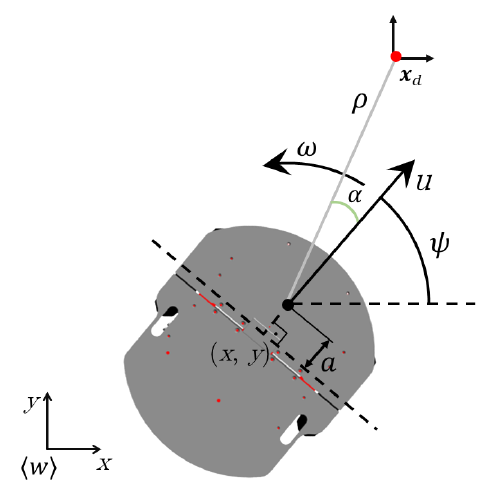
Figure 6. The UGV seeking for its destination x d